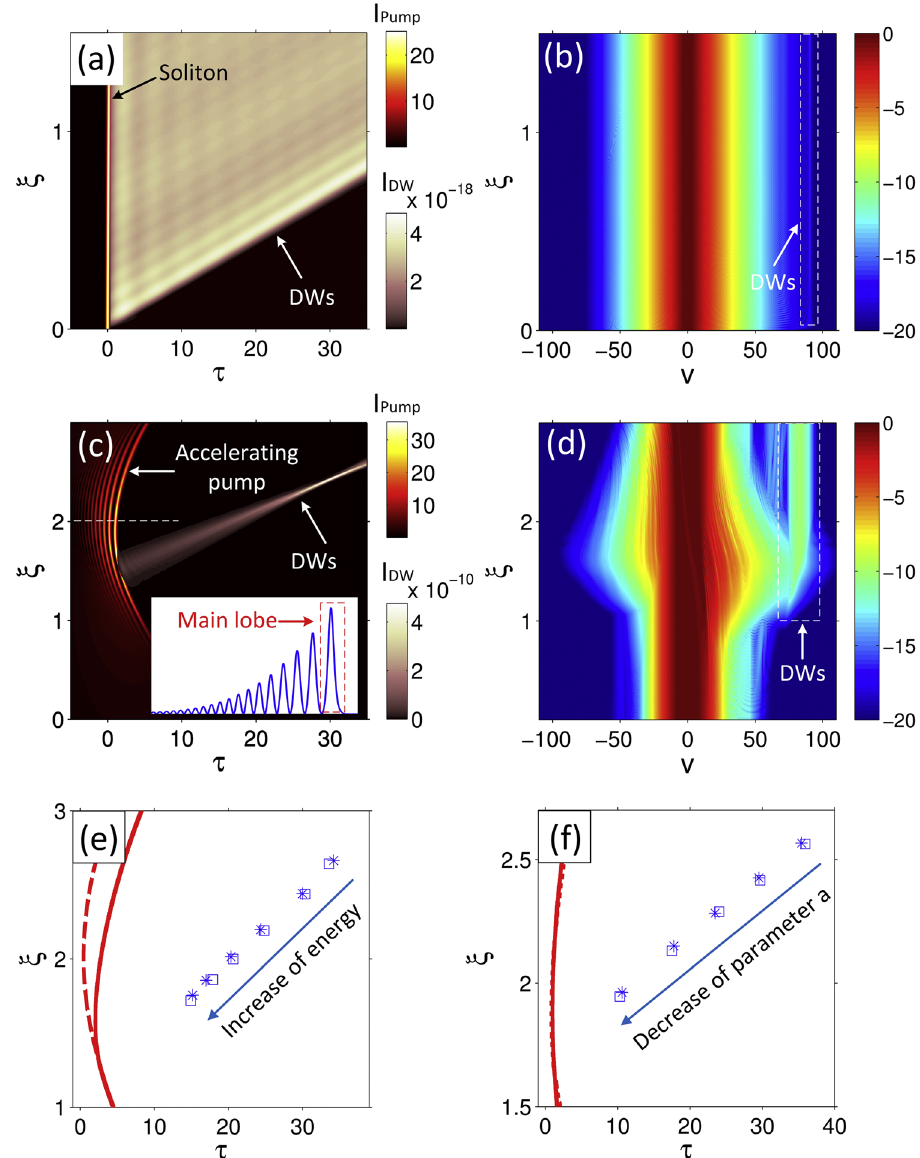
Figure 3. Generation and evolution of DWs when the pump pulse is either a soliton (Row 1) or an Airy pulse (Rows 2 and 3). ( a , c ) Numerical results for the temporal evolution of the pump pulse (hot-color) superimposed with the associated generation of DWs (in pink – retrieved by spectral filtering). Since the intensities of DWs are significantly lower than those of the pumps, different color scales are used for a better visualization. The inset in ( c ) depicts the temporal profile (featured by a main lobe) of the accelerating pulse at a selected distance (marked by the horizontal dashed line). ( b , d ) show the corresponding spectral intensity evolution (in a logarithmic scale). Note that the dashed rectangle highlights the generated DW spectral components. Row 3 illustrates the possibility to control the DW compression by linearly tuning either the normalized pulse energy from 20 to 120 ( e ), or the pump pulse acceleration (i.e., the value of the parameter a ) from 0.024 to 0.032 ( f ). The locations of the DW converging points are calculated, for each case, from both theory (stars) and numerical simulations (squares). Correspondingly, the dashed (solid) lines represent the trajectory followed by the pulse main lobe for the minimum (maximum) input power in ( e ), or the maximum (minimum) acceleration in ( f ). Note that all the values are